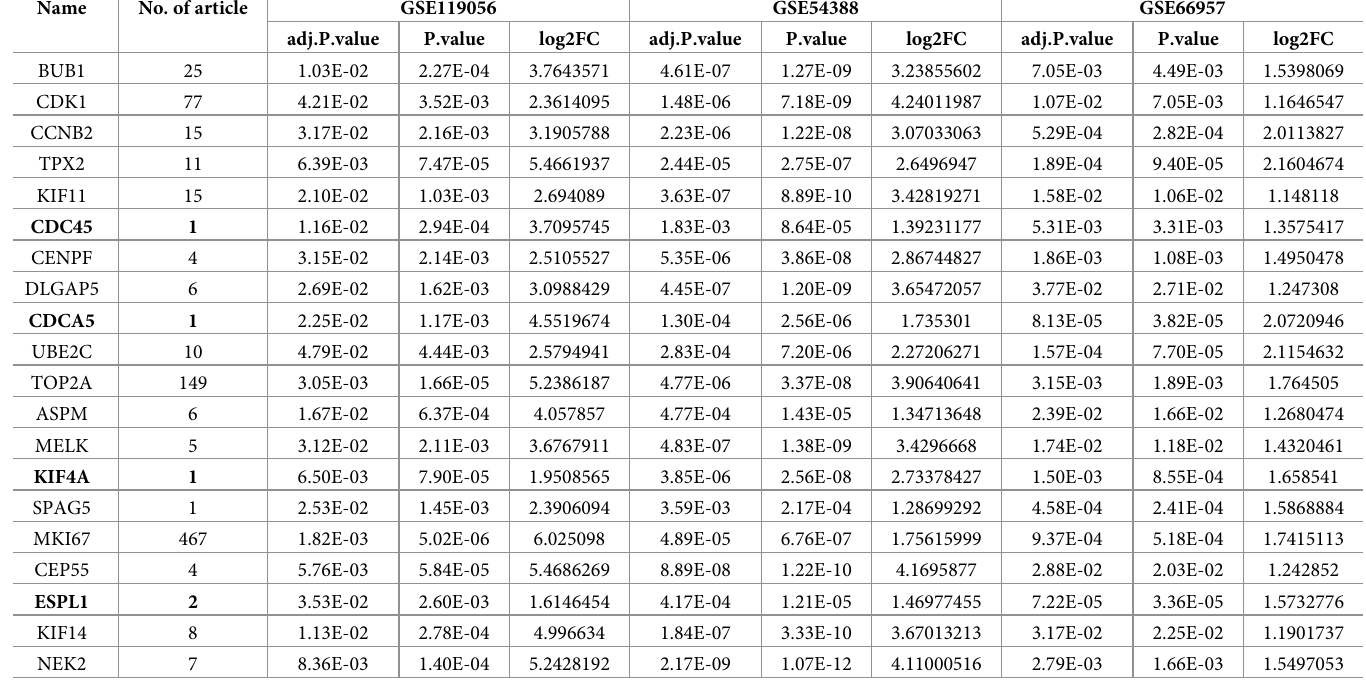
Table 2. Literature retrieval of the top 20 Hub genes in three GSE